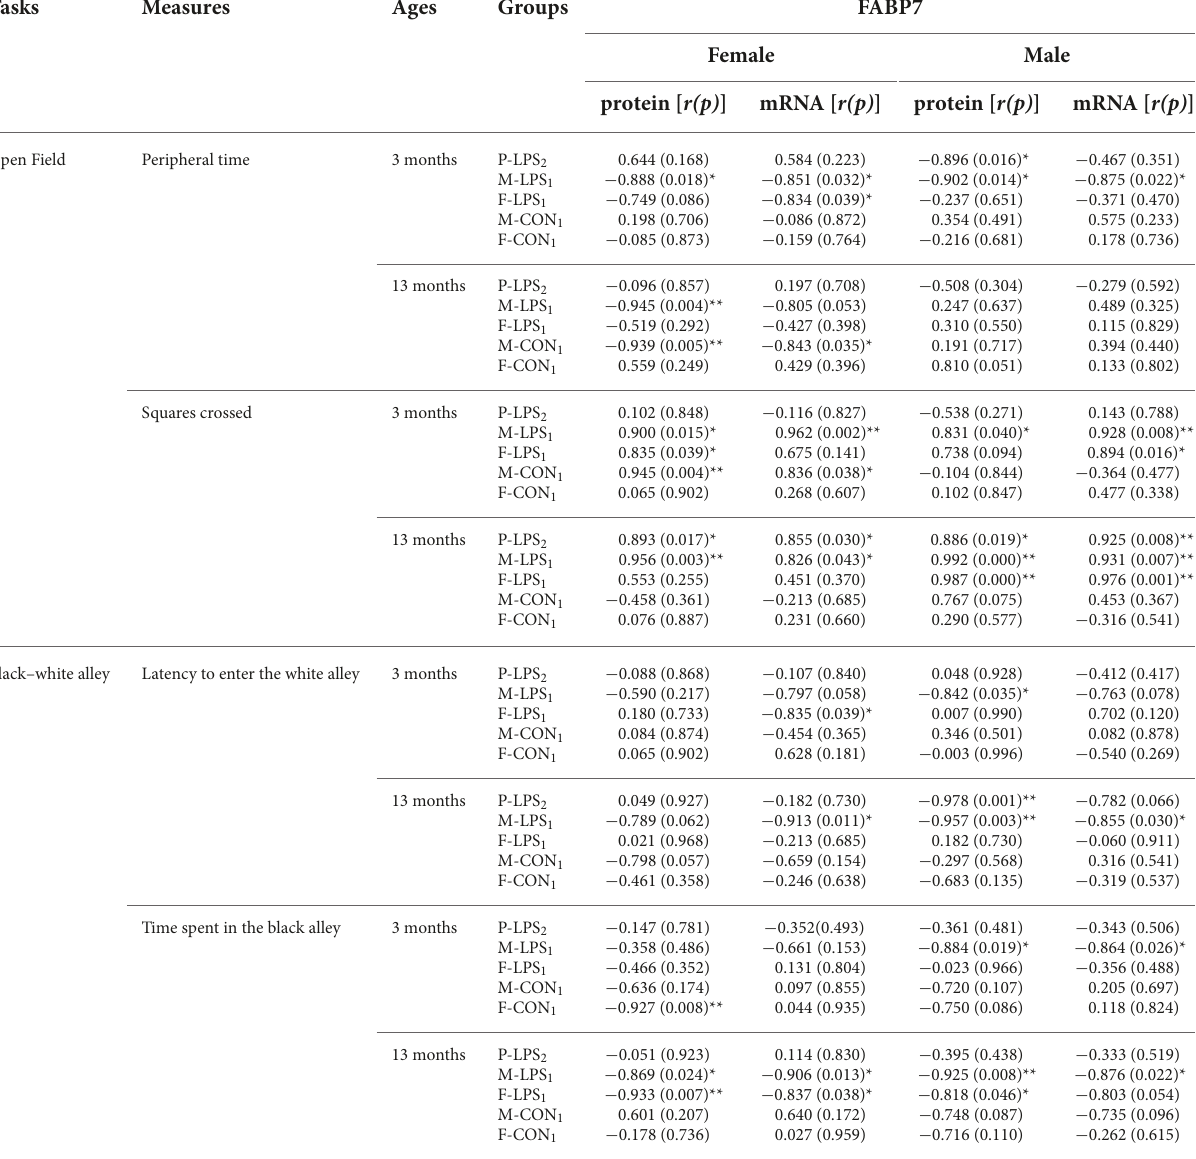
TABLE 4 The correlations between performance in anxiety-related tasks and hippocampal FABP7 protein and mRNA levels in F2 offspring. Tasks Measures Ages